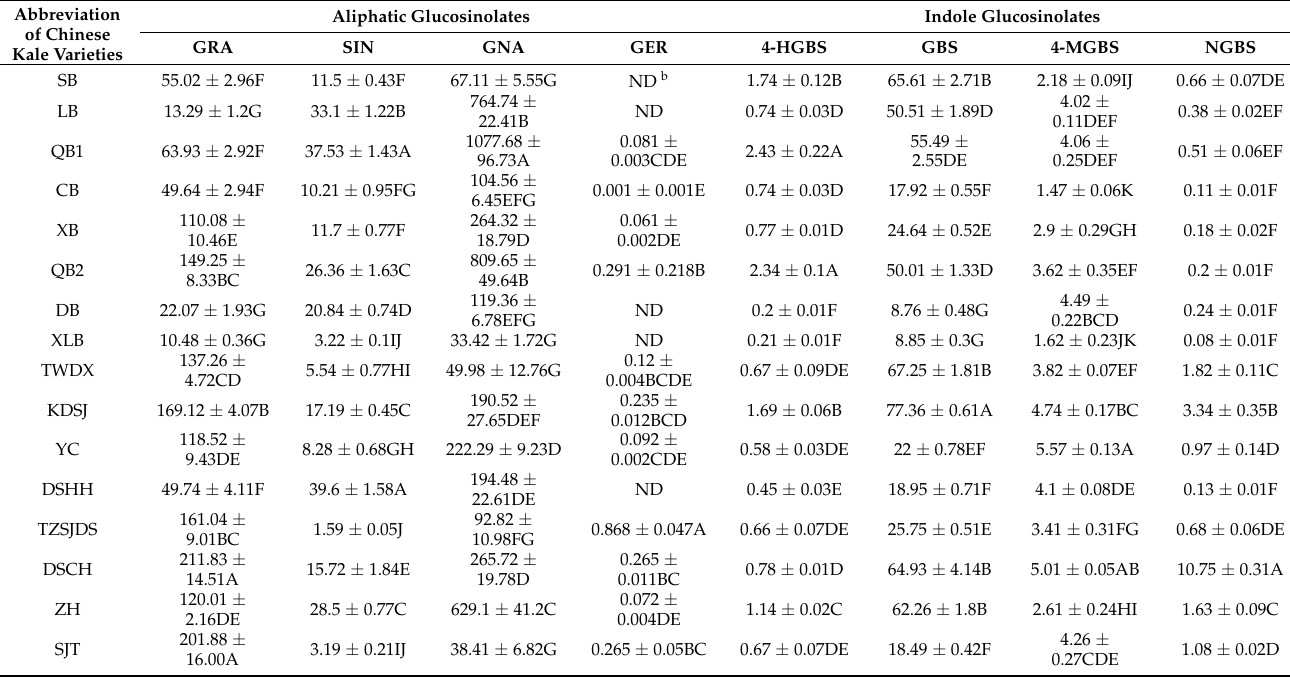
Table 4. Composition and accumulation of glucosinolates ( µ mol/100 g DW a ) in the edible leaves of 16 varieties of Chinese